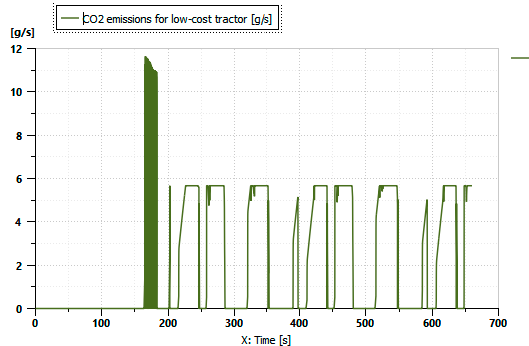
Figure 10. The variation in the CO 2 release.